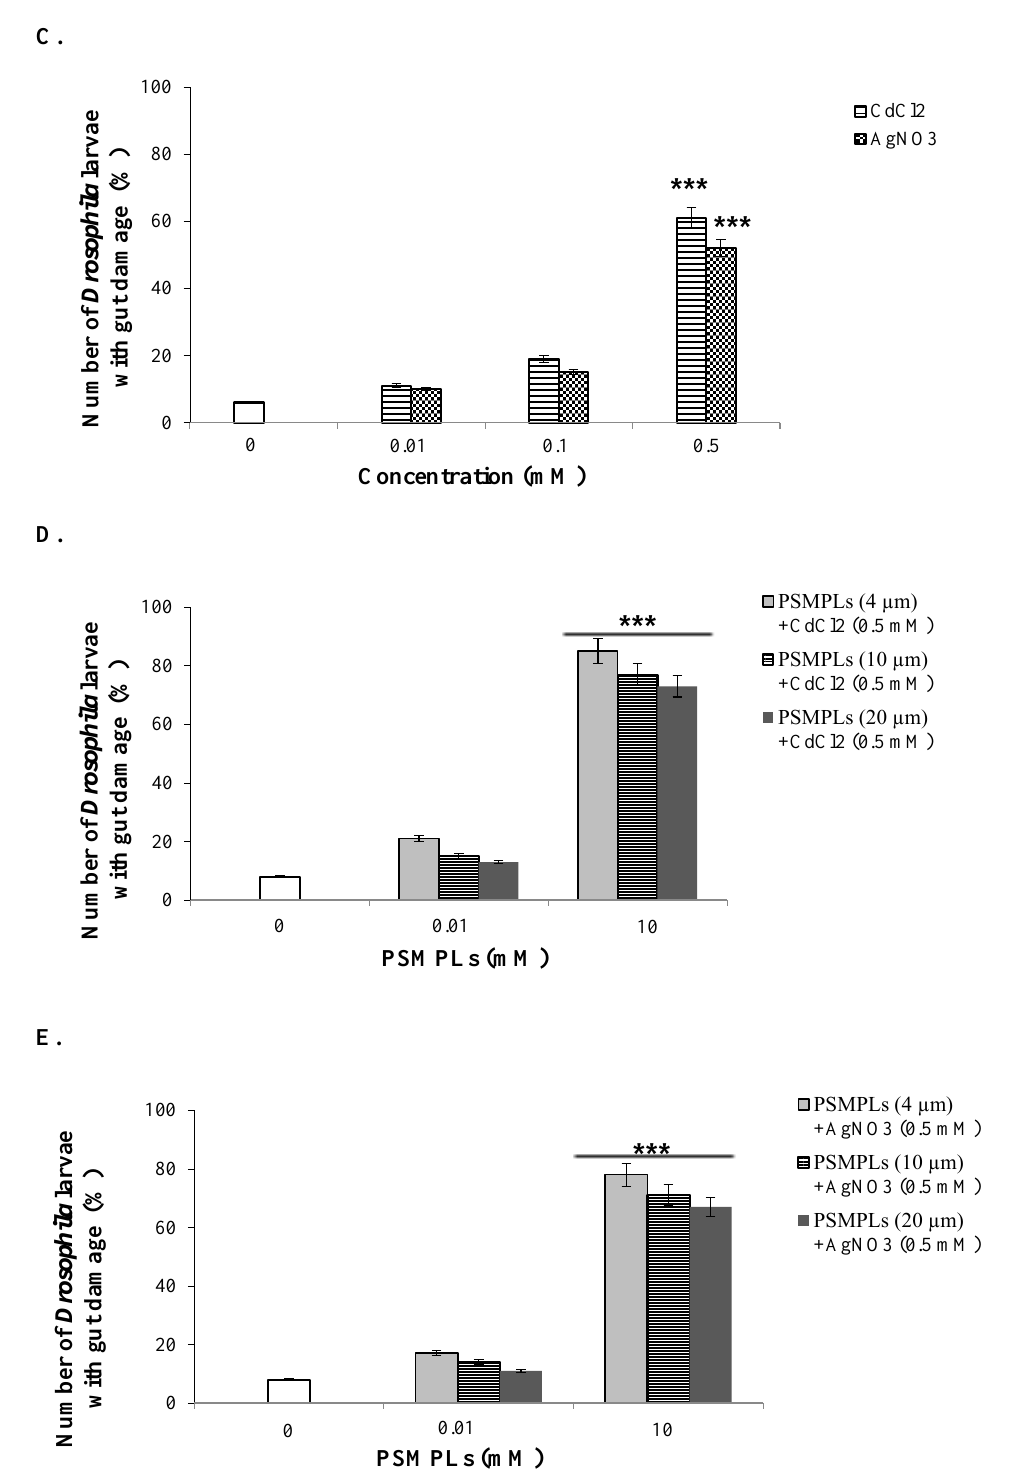
Figure 1. Intestinal damage in third-instar larvae after exposure to PSMPLs, CdCl 2, AgNO 3 , PSMPLs + CdCl 2 , and PSMPLs + AgNO 3 . ( A ) Trypan blue staining of damaged tissue was only observed in treated larvae (presence of gut damage). No tissue damage was observed in the control larvae. Percentage of gut damage in larvae after exposure to PSMPLs ( B ), CdCl 2 and AgNO 3 ( C ), PSMPLs + CdCl 2 ( D ), and PSMPLs + AgNO 3 ( E ). Data were analyzed by Mann–Whitney U -test. *** p ≤ 0.001, as compared to